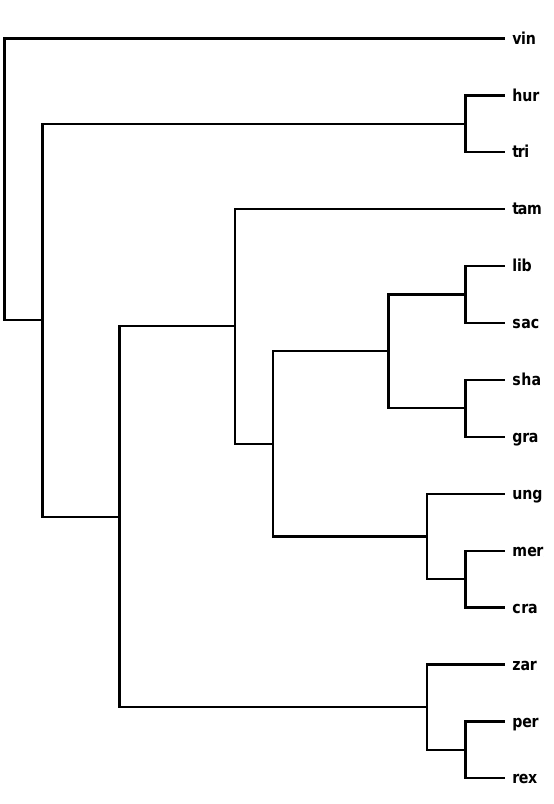
F IGURE 3. Rrooted tree of Meriones species which shows phylogenetic relationship. Lib ( M. libycus ); per( M. persicus ); cra( M. crassus ); mer( M. meridianus ); tri( M. tristrami ); vin( M. vinogradovi ); rex ( M. rex ); sac( M. sacramenti ); sha( M. shawi ); gra( M.grandis ); hur( M. hurrianae ); tam( M. tamariscinus ); ung( M. unguiculatus ); zar( M. zarudnyi